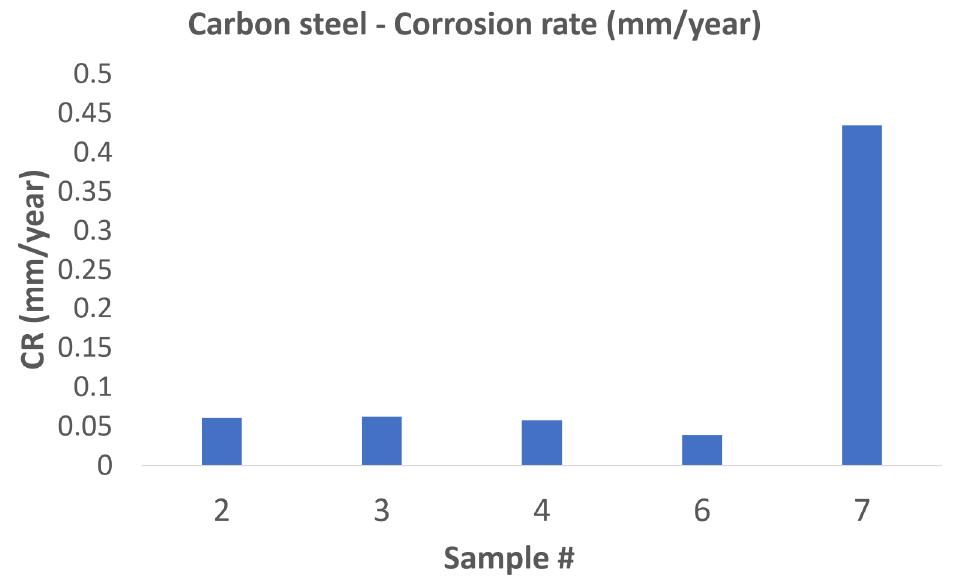
Figure 18. Weight loss analysis of carbon-steel samples. Samples 2 and 3 were accommodated in the 1st reactor, samples 4 and 6 in the 2nd reactor and sample 7 in the 3rd reactor.